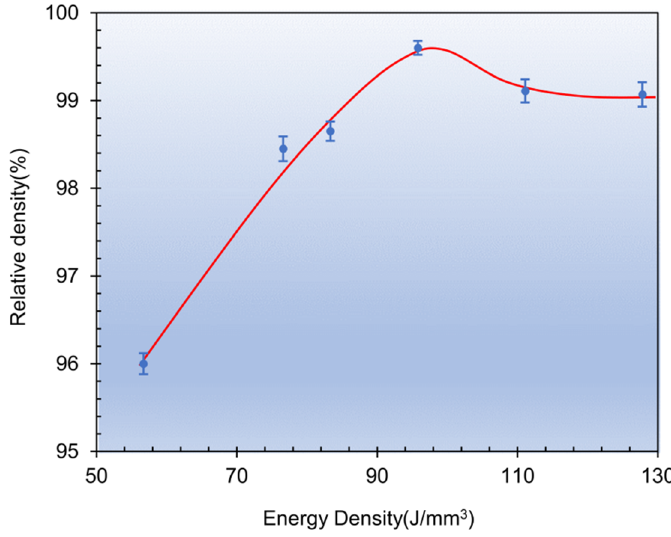
Figure 4. The relative density of as-SLMed H13 samples with different VEDs.